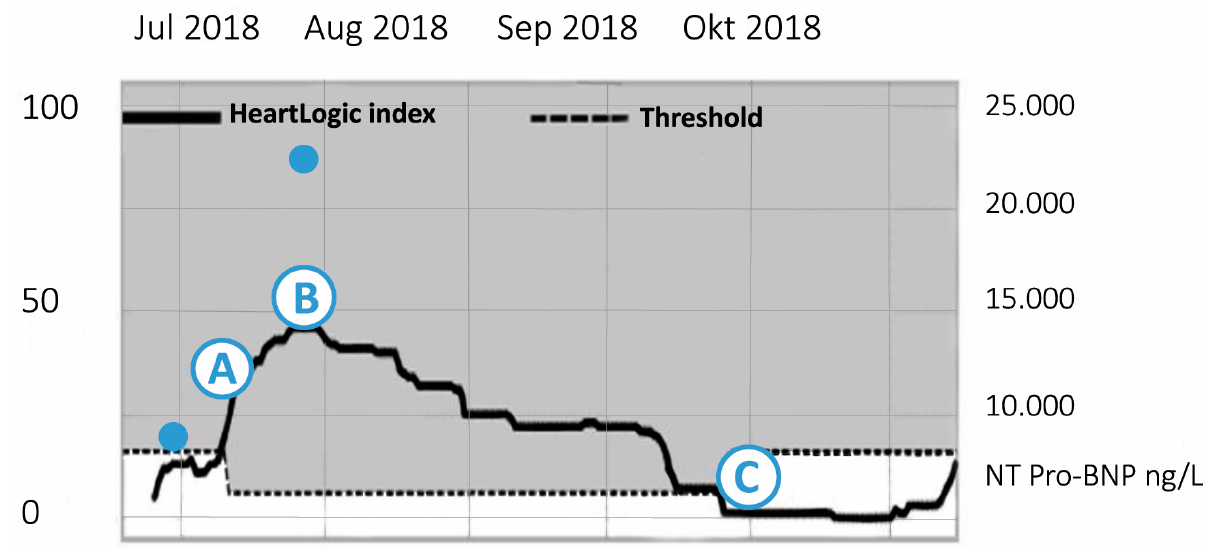
Figure 7. The course of HeartLogic index of patient described in Case 3. A (17 July): Phone contact. HeartLogic TM index raises to 38. B (14 August): Phone contact. HeartLogic TM index 50, NT-pro BNP (N-terminal B-type natriuretic peptide) 22.919 ng/L. C (26 October): Phone contact. Gradual decline of HeartLogic TM until 0.